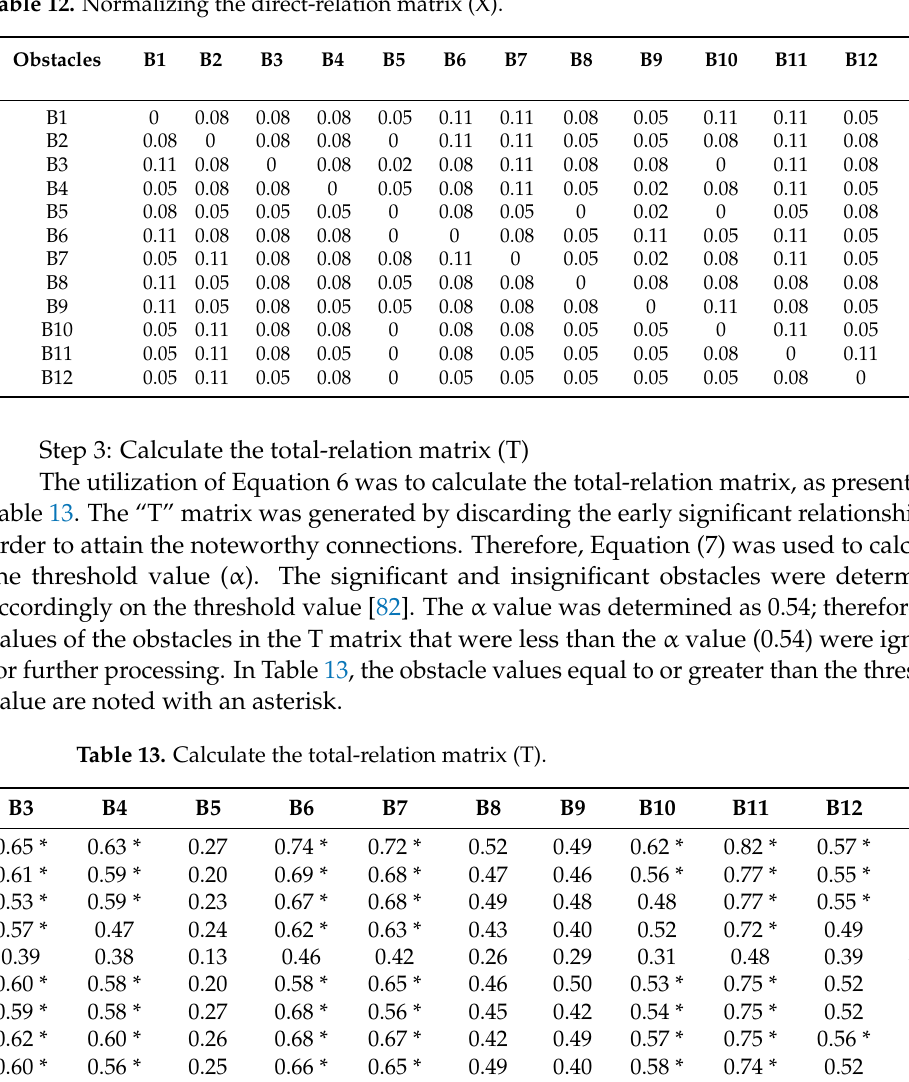
Table 12. Normalizing the direct-relation matrix (X).